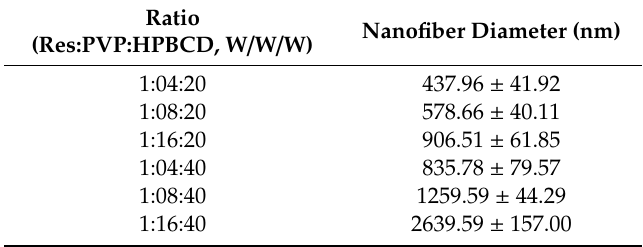
Table 3. Nanofiber diameter for di ff erent ratio formulations of resveratrol nanofibers determined by scanning electron